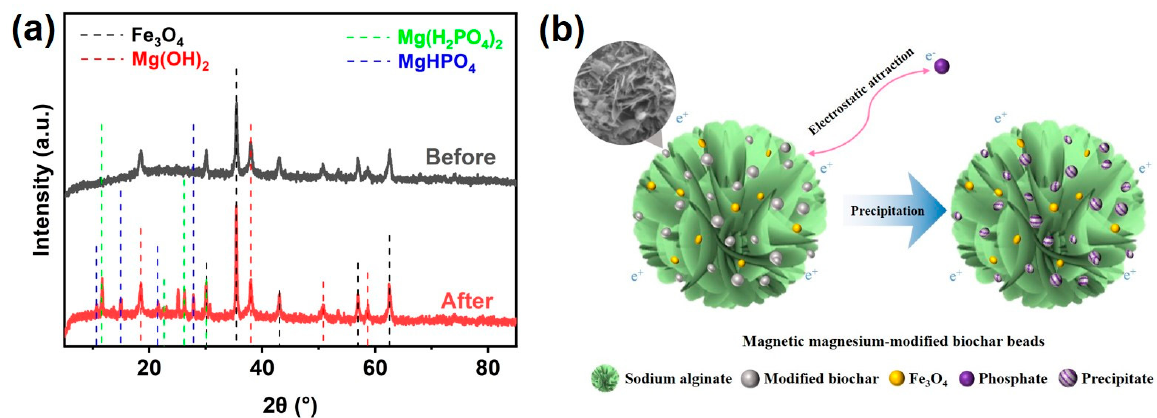
Figure 6. ( a ) XRD spectra of FeSA-MgBC-3 before and after adsorption. ( b ) Schematic representation of the mechanism of interaction with phosphate removal. of the mechanism of interaction with phosphate